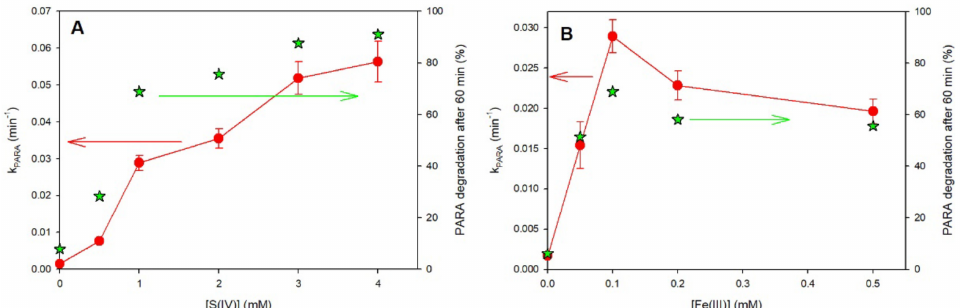
Figure 4. First order rate constant of PARA degradation (k PARA ) (filled circles) and degradation effi- ciency in percentage after 60 min (green stars) as a function of S(IV) ( A ) and Fe(III) ( B ) concentrations under UVA in aerated solutions. Conditions: [PARA] 0 = 10 µ M, [Fe(III)] 0 = 0.1 mM, [S(IV)] 0 = 1.0 mM, pH init =